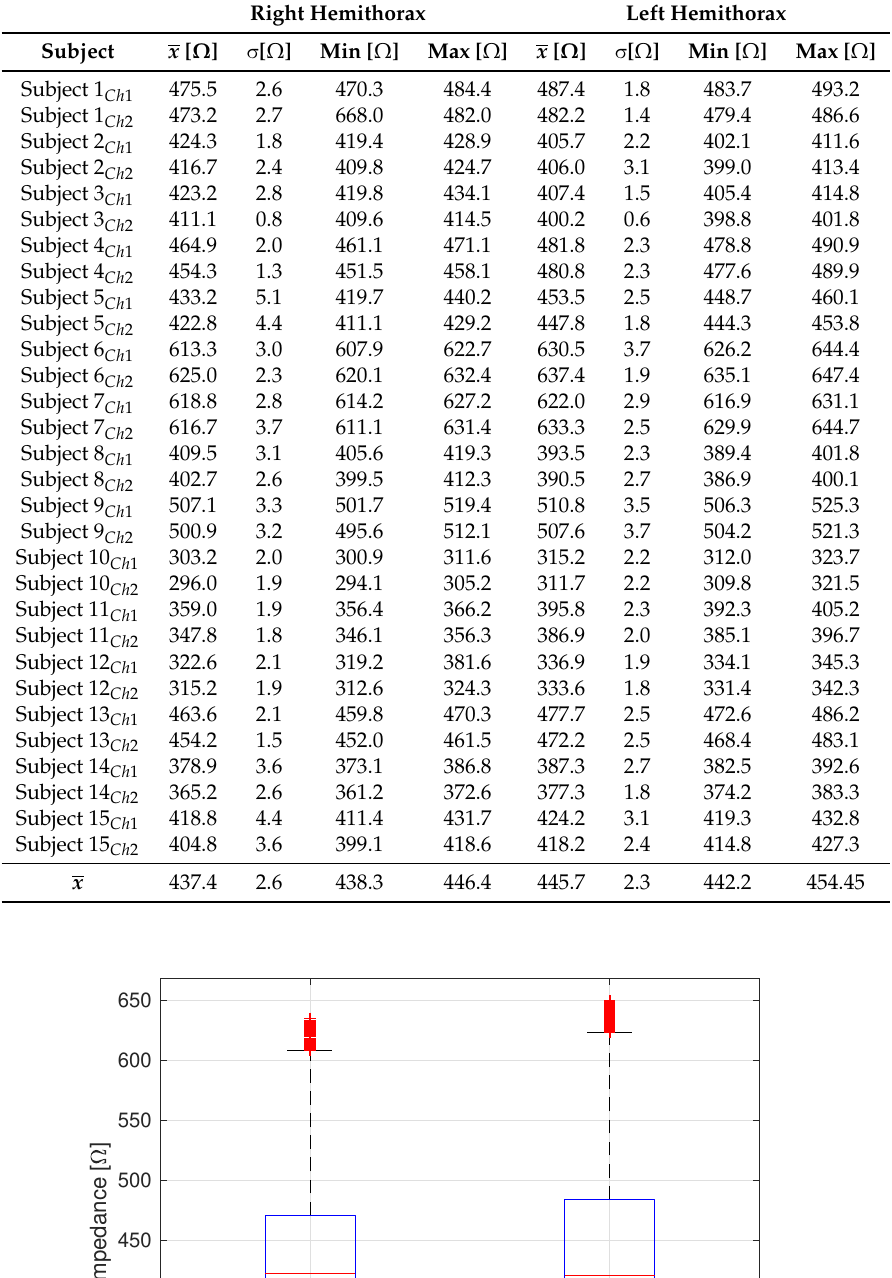
Table 1. TEB values obtained from signals analysis by channel and hemithorax. Subject X Ch 1 means that the Channel 1 measures the right hemithorax and Channel 2 measures the left hemithorax, while Subject X Ch 2 means that the Channel 2 measures the right hemithorax and Channel 1 measures the left hemithorax.